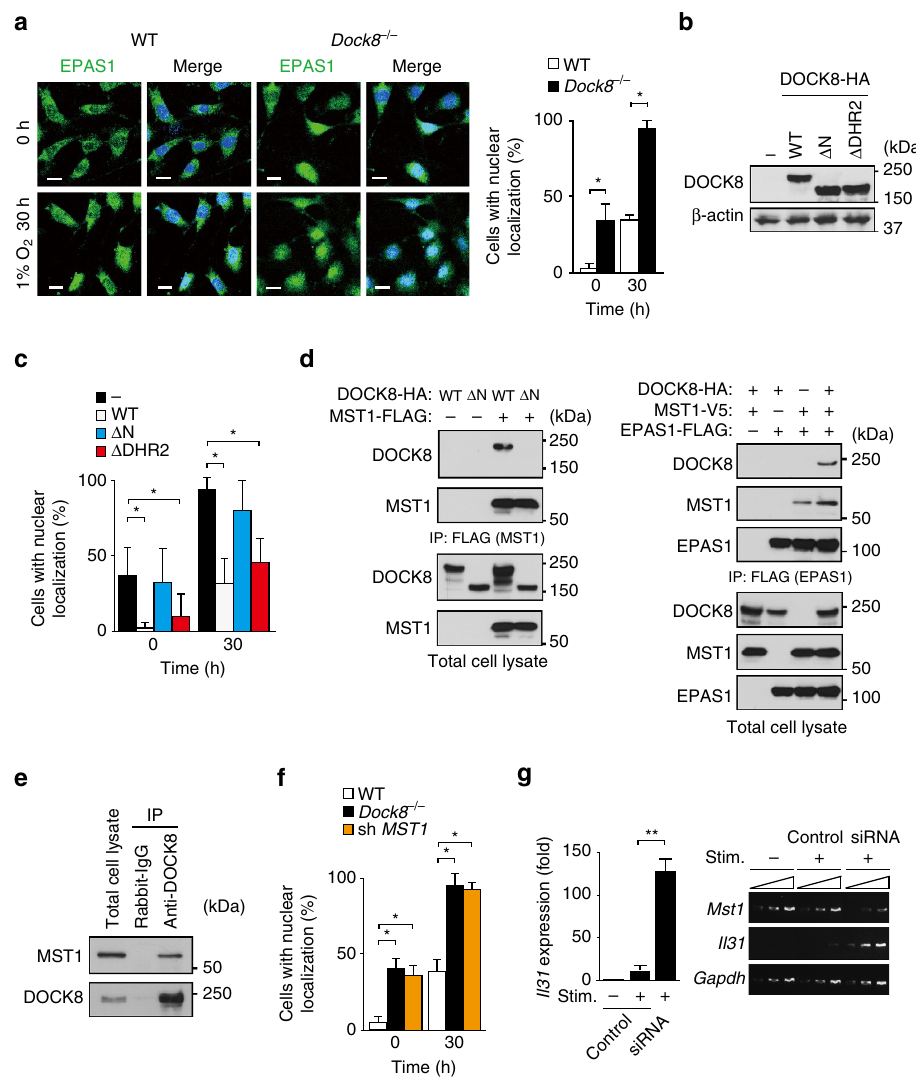
Figure 6 | DOCK8 regulates nuclear translocation of EPAS1 via MST1 interaction. ( a ) Immunofluorescence analyses for subcellular localization of EPAS1 in MEFs under steady and hypoxia conditions. DAPI was used to stain nuclei. Scale bars, 20 m m. The proportion of cells with nuclear localization of EPAS1 was compared between WT and Dock8 (cid:2) / (cid:2) MEFs. In each experiment, 30 cells were counted per group. Data are expressed as mean ± s.d. of 4 independent experiments. * P o 0.05 (two-tailed Mann–Whitney test). ( b , c ) Comparison of nuclear localization of EPAS1 between Dock8 (cid:2) / (cid:2) MEFs and those stably expressing HA-tagged WT DOCK8 or its mutants ( D N and D DHR2). Western blot analysis was performed with anti-HA and anti- b actin antibodies. In each experiment, 30 cells were counted per group. Data are expressed as mean ± s.d. of four independent experiments. * P o 0.05 (two-tailed Mann–Whitney test). ( d ) Formation of DOCK8-MST1-EPAS1 molecular complex in HEK-293T cells. 24h after transfection of the expression experiments. ( e ) Association between DOCK8 and MST1 in activated CD4 þ Tcells. The cell extracts of activated CD4 þ Tcells were